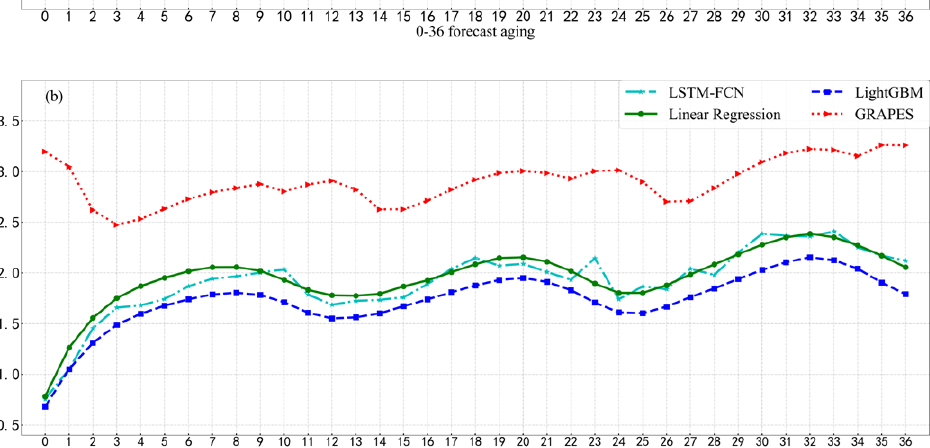
Figure 5. RMSE ( a ) and MAE ( b ) values of the GRAPES-3km model and the three correction methods at forecast timelines from 0 to 36 h.